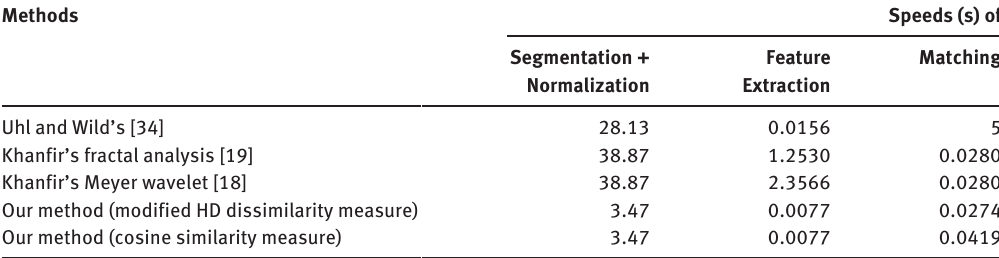
Table 2. Comparisons of the Computational Cost.